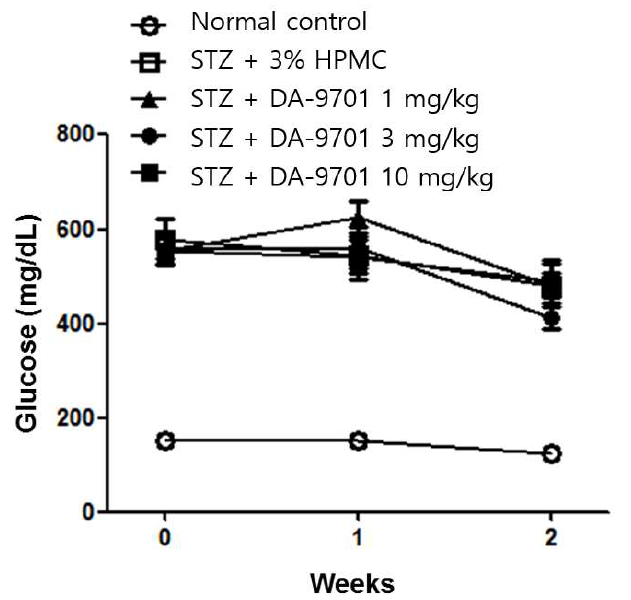
Figure 3. Effect of DA-9701 on blood glucose level in normal control and streptozotocin-induced diabetic mice. Streptozotocin-induced diabetic mice showed significantly higher blood glucose levels than control. DA-9701 did not affect blood glucose level in the streptozotocin-induced diabetic mice. (n = 10 in each group).